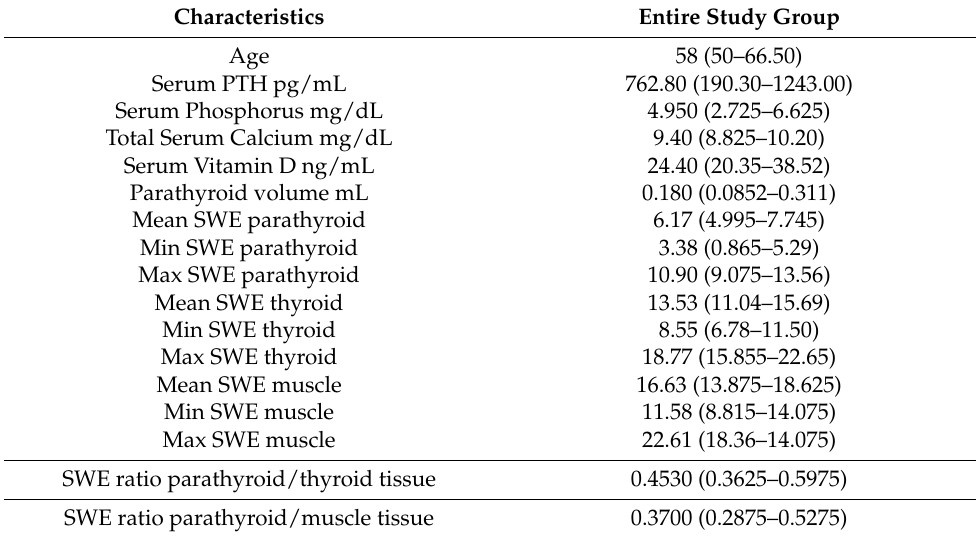
Table 2. Baseline characteristics of the entire studied group. SWE: shear wave